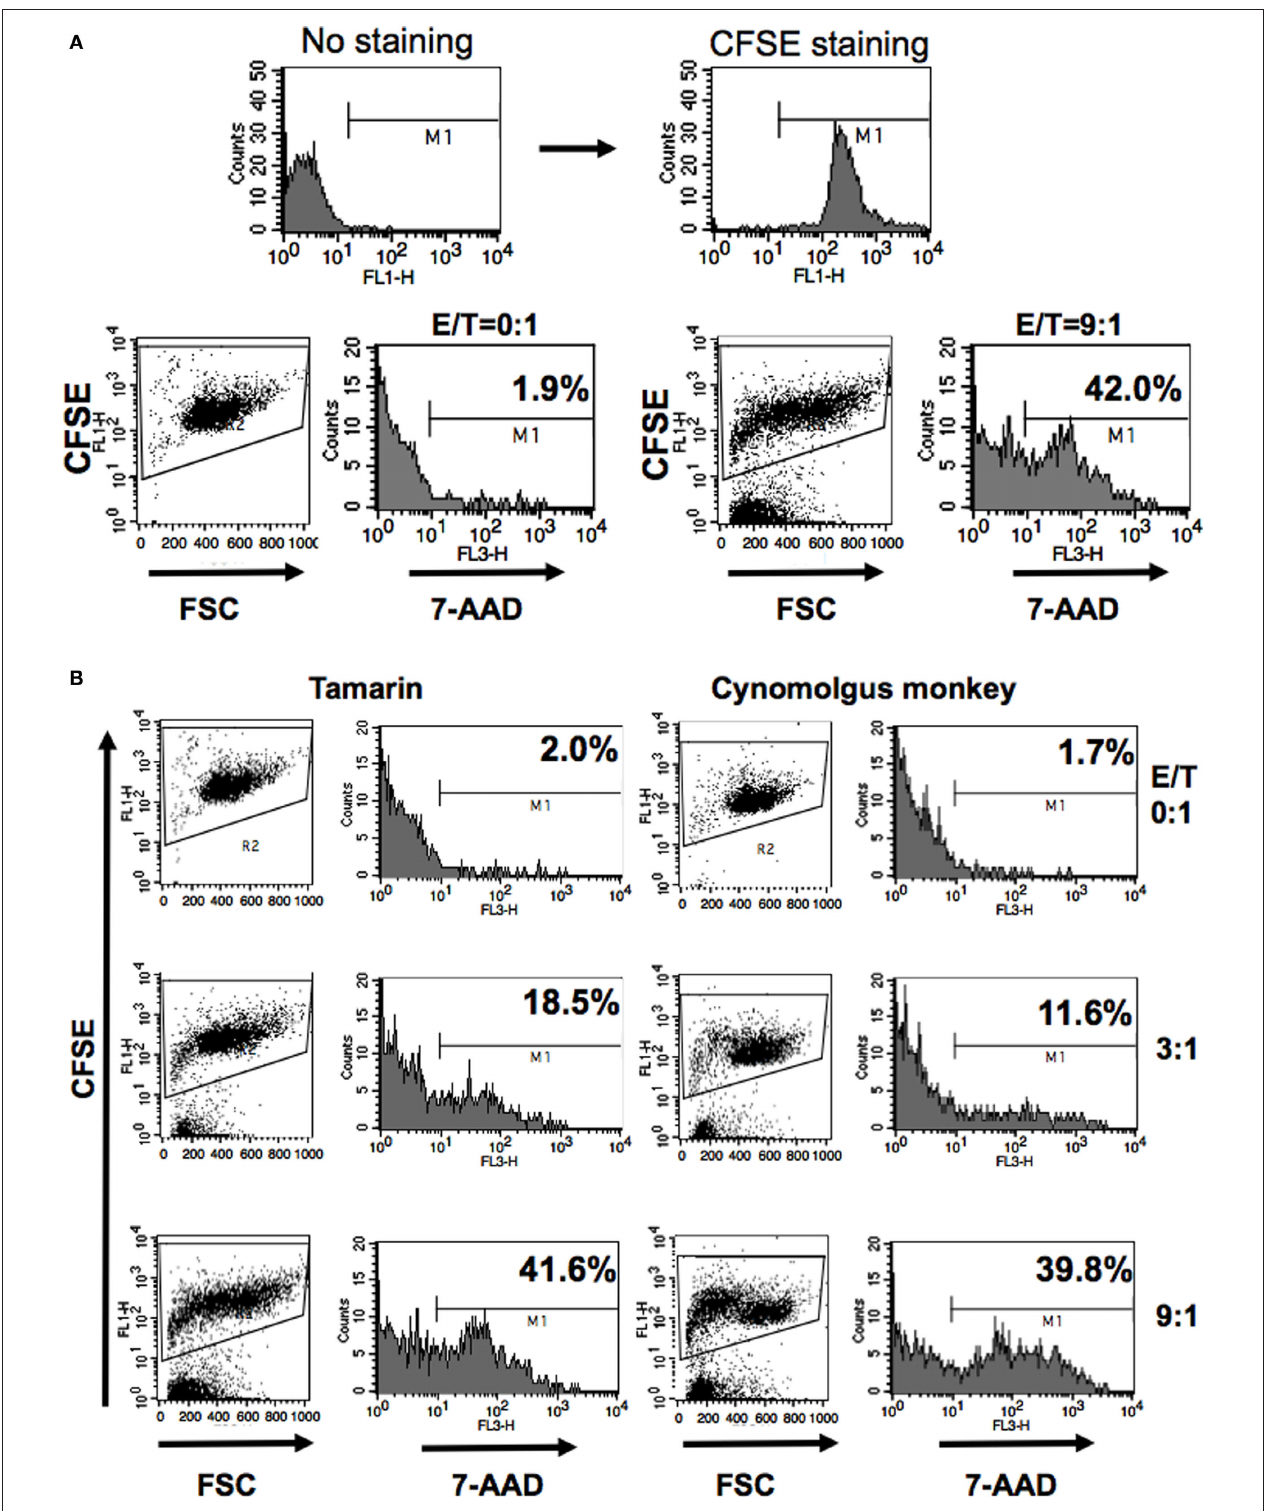
target cells were killed by tamarin PBMCs using E/T ratios of 9:1, 3:1, and 0:1. The numbers in the panels denoted the percentages of 7-AAD positive cells. We analyzed statistically whether these killing activities were different between tamarins and cynomolgus monkeys by using StatView